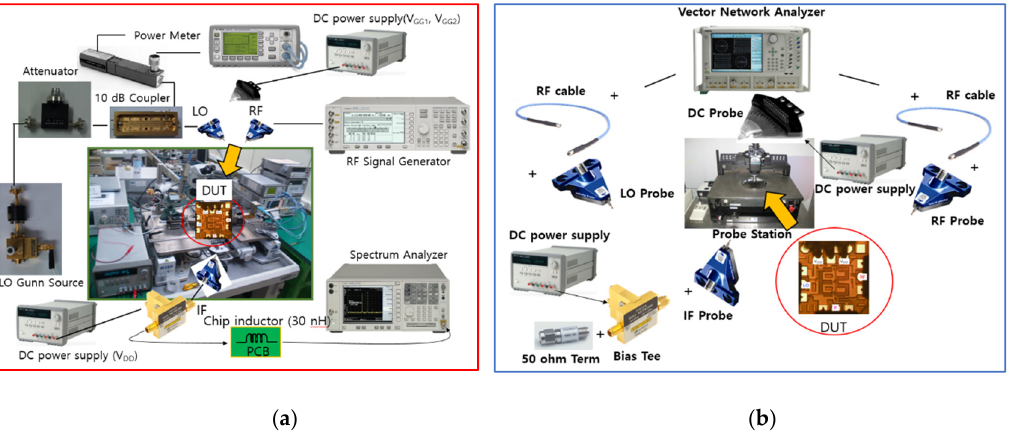
Figure 16. Measurement setup of the fabricated mixer (( a ) CG, ( b ) return loss and isolation).